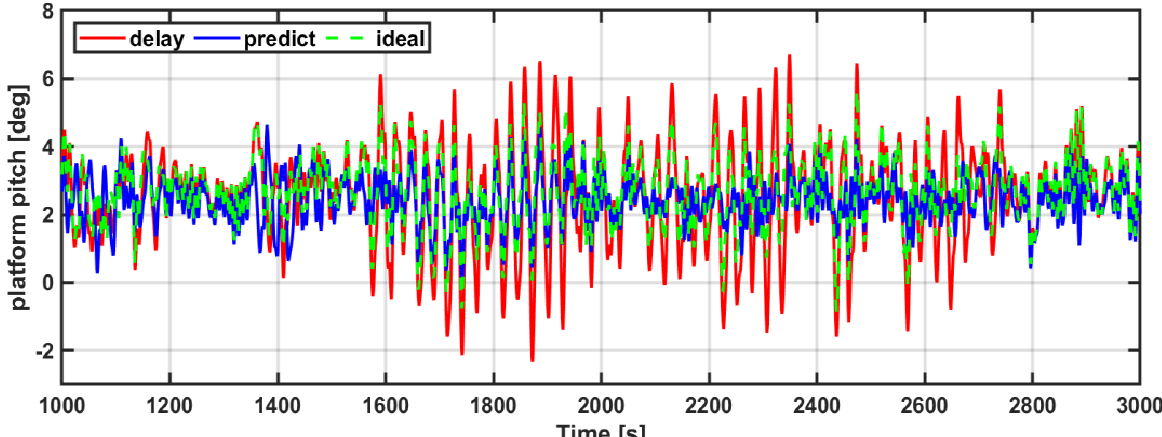
Figure 16. Platform pitch angle of floating offshore wind turbine by pitch controller.